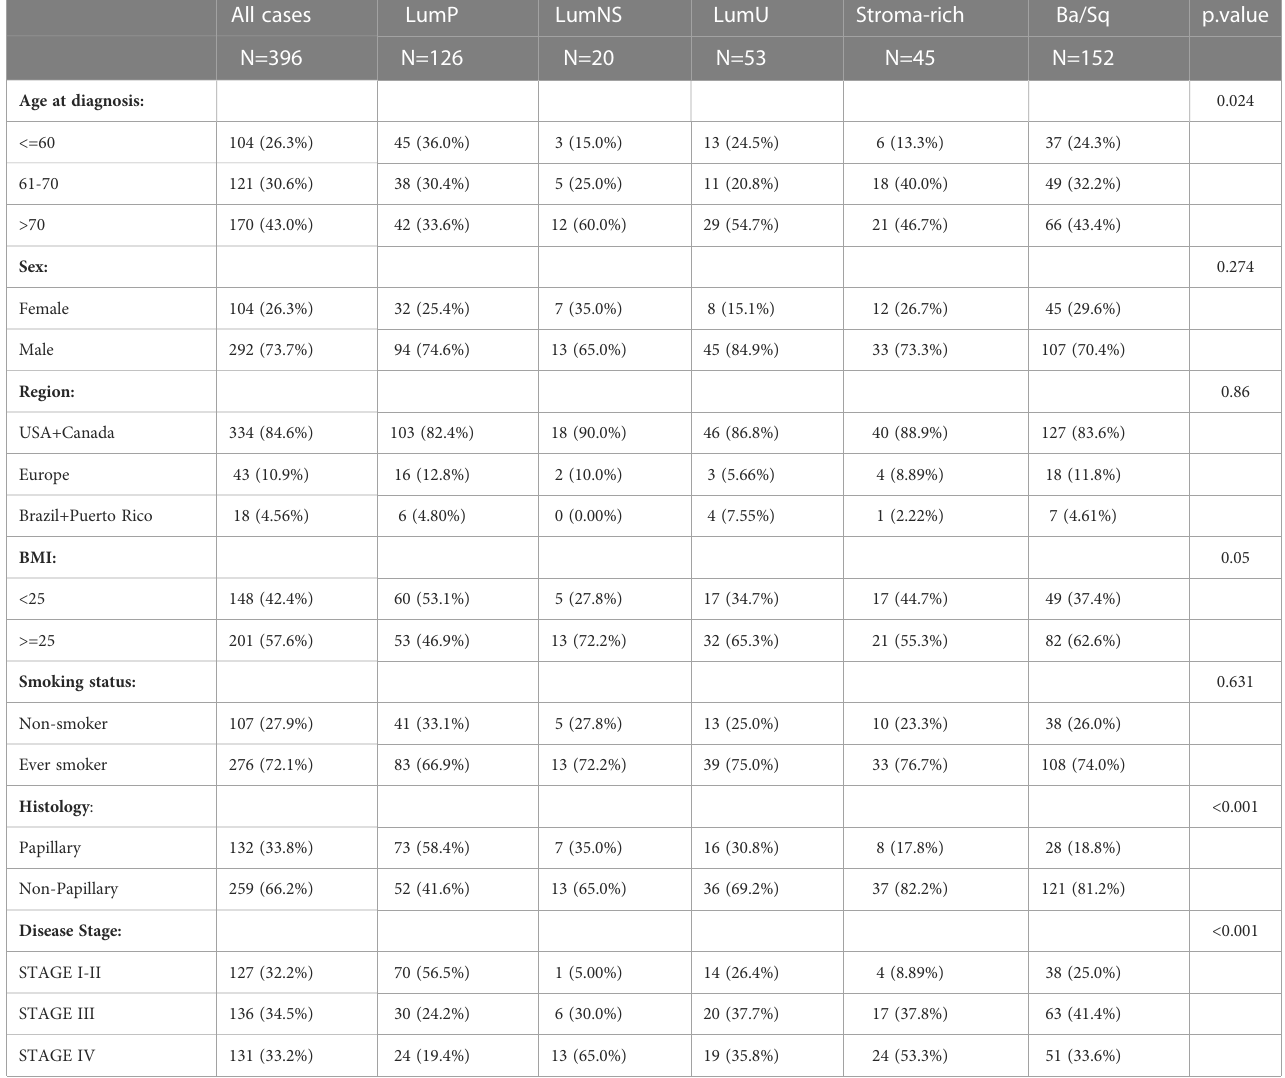
TABLE 1 Sociodemographic and clinical features for MIBC cases according to